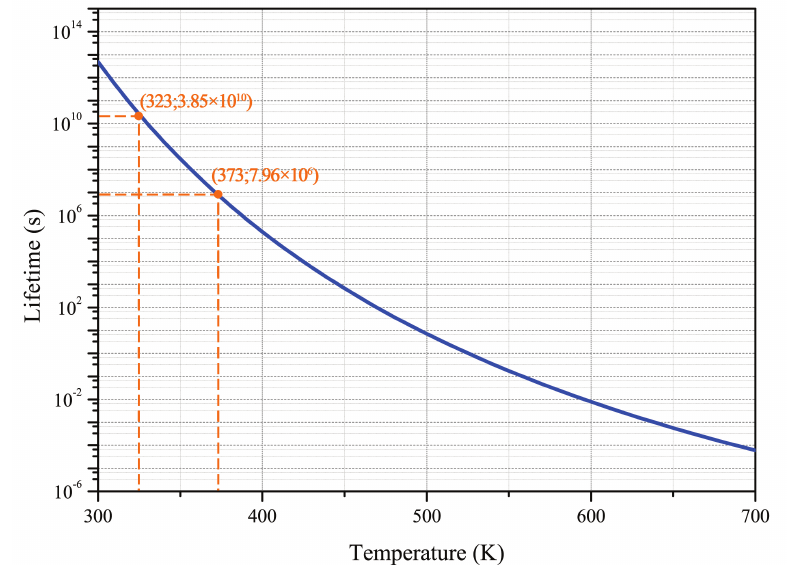
Figure 5. Lifetime as a function of temperature for the animal